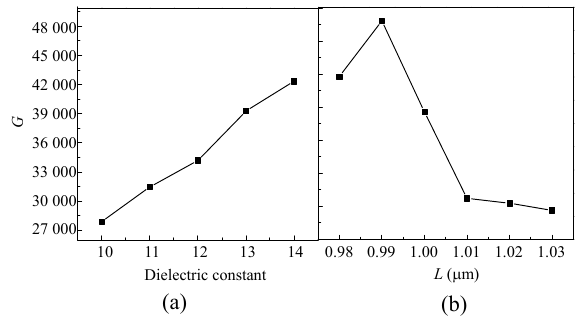
Fig. 3 Energy density ratio G as the dielectric constant  and the thickness L of the dielectric slab: (a) energy density ratio G as a function of the dielectric constant  and (b) energy density ratio G as a function of the thickness L of the dielectric slab.